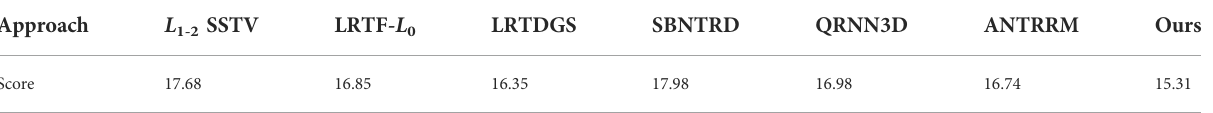
TABLE 3 No-Reference Hyperspectral Image Quality Assessment on the GF-5 Baoqing image.